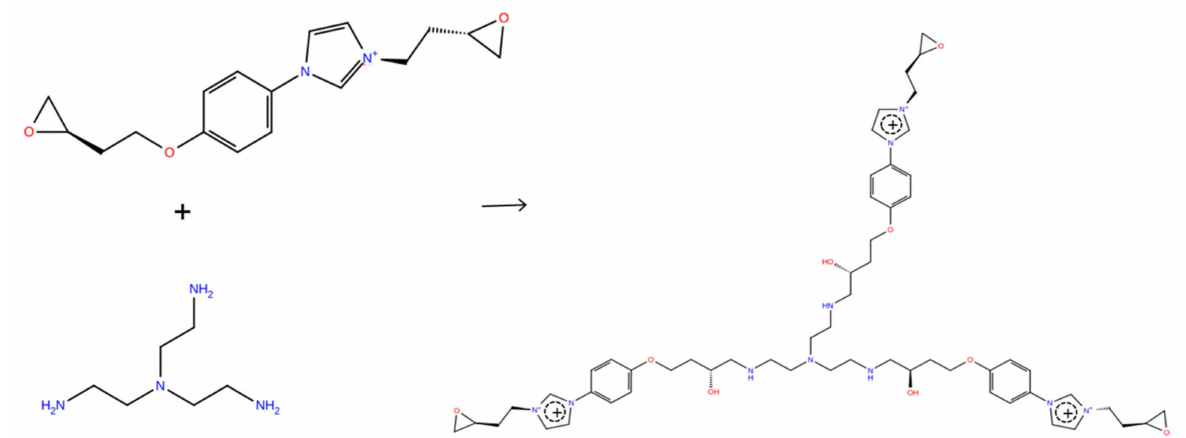
Figure 2. A representation of the cross-linking processes and their networked structures, obtained by reactions of cationic EIM2 monomers and tris(2-aminoethyl)amine (TAEA) curing agent. The network structure propagates by cross-linking processes in the three-dimensional space, where the stoichiometry for EIM2 monomers and TAEA is set to be 3:2 in the system, paired with anions to neutralize the total